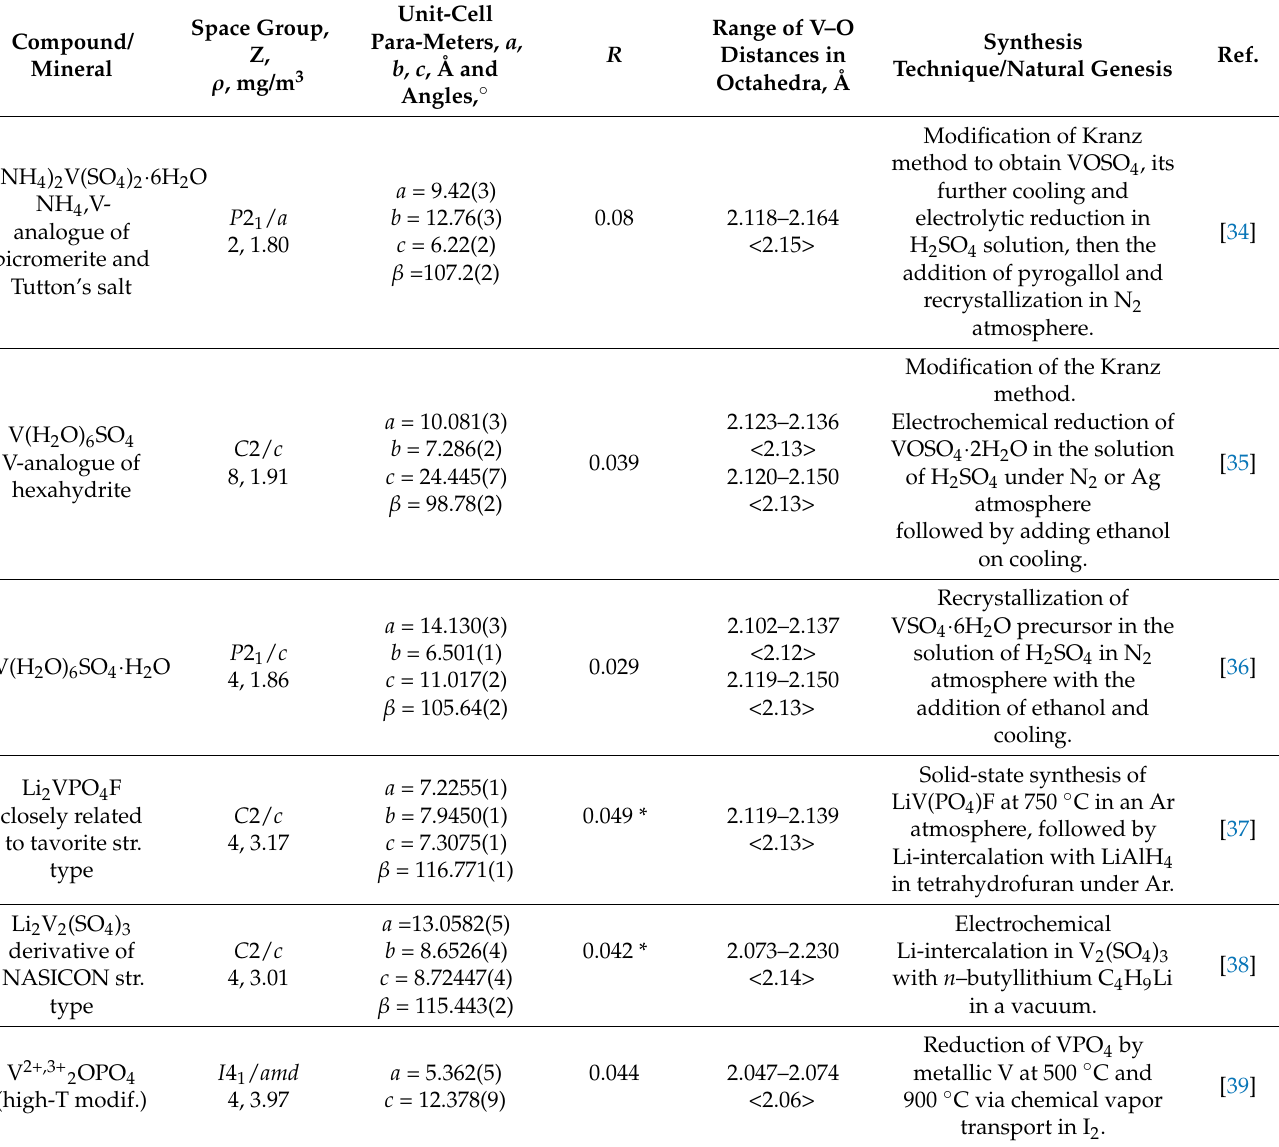
Table 5. Synthetic and natural oxygen-containing inorganic compounds with divalent